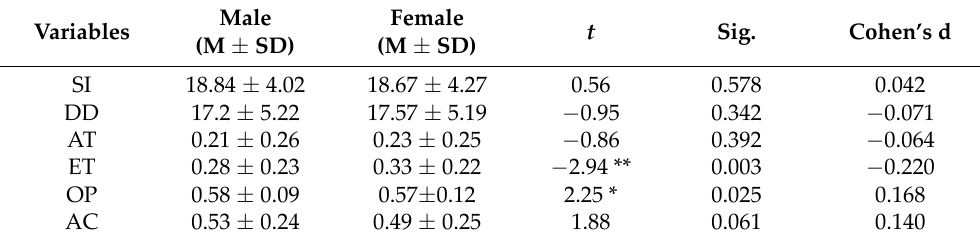
Table 5. Gender differences in measured variables ( n = 734: male = 309, female = 425). Variables